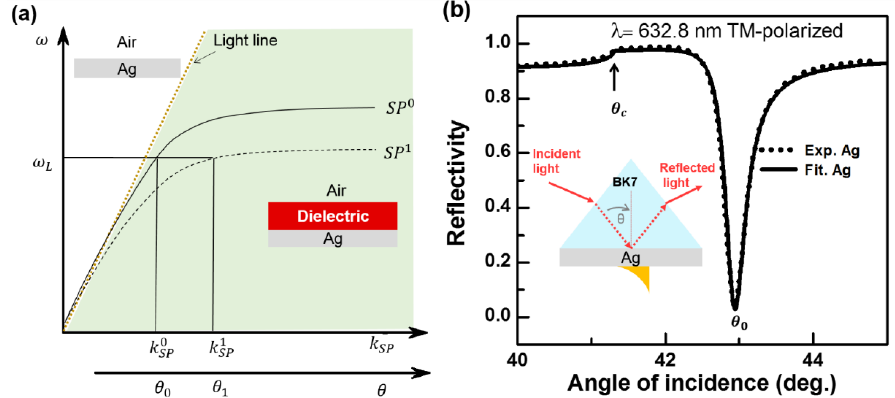
Figure 2. ( a ) Dispersion relation of SPs (i.e., 𝜔 vs 𝑘 𝑆𝑃 (e.g., Equation (1)), referring to the SP at an Ag-air interface ( 𝑆𝑃 0 ), and when a thin dielectric coating (DC) is deposited on the Ag layer ( 𝑆𝑃 1 ). The light line is also indicated in this figure. A light frequency 𝜔 𝐿 crosses the dispersion curves at 𝑘 𝑆𝑃0 and 𝑘 𝑆𝑃1 , and it determines the coupling angle 𝜃 0 and 𝜃 1 , for 𝑘 𝑆𝑃0 and 𝑘 𝑆𝑃1 , respectively. The thin DC shifts the SP dispersion curve to higher coupling ( 𝑘 𝑆𝑃1 = 𝑘 𝑆𝑃0 + 𝛥𝑘 𝑆𝑃 , i.e., resonance, angle, and momentum). ( b ) Experimentally observed SPR at a prism/Ag (thickness~56 nm) system with a 638 nm laser light. The scatters are experimental data points, and the solid curve is a Fresnel’s theoretical fit.